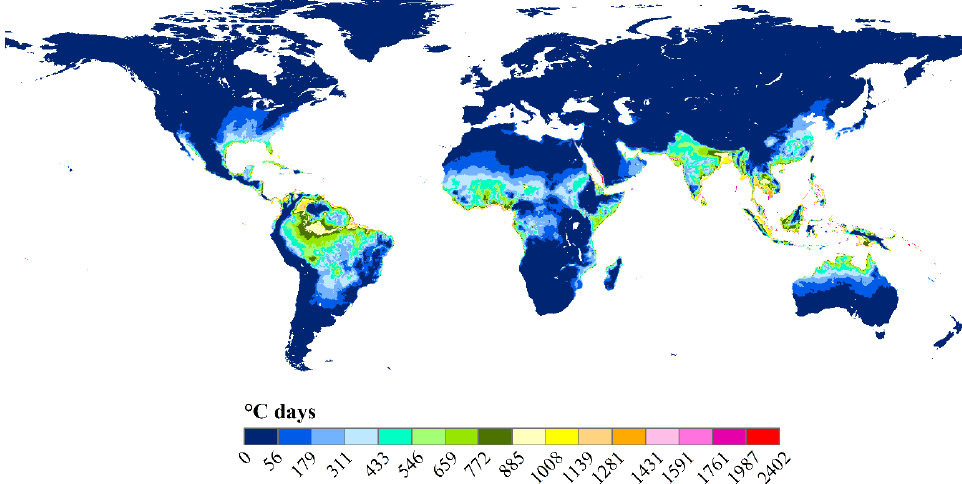
Figure 2. Global cooling degree days accounting for humidity by setting the base temperatures as 18 ◦ C. The data were derived from http://hs.pangaea.de/model/MistryM_2019a/CDD_wetbulb_GeoTIFF.tar.gz [33]. The classification thresholds were determined by the natural break